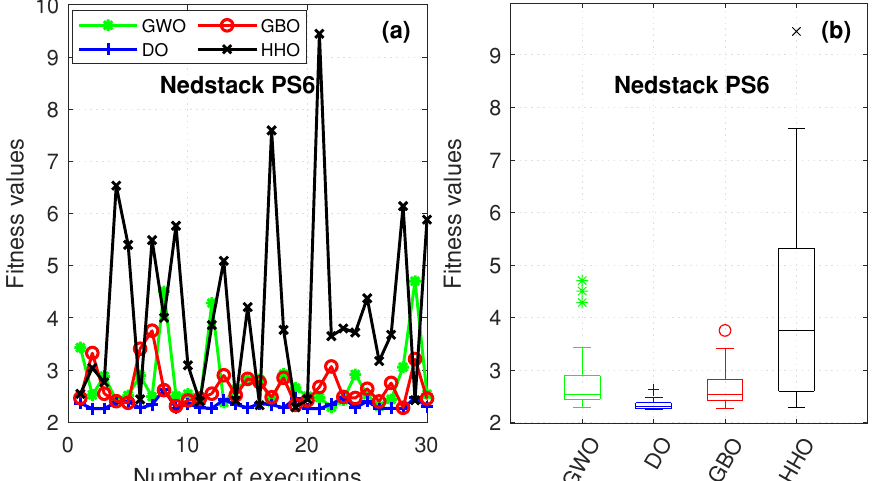
Figure 5. The statistical study of the NedStack PS6: ( a ) best values of the objective function; ( b ) boxplot of